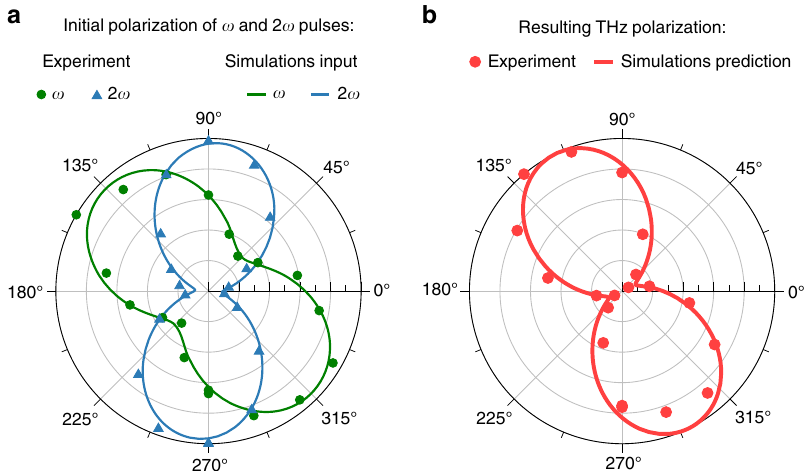
Fig. 3 Polarizations of laser and THz pulses. a . Initial polarization of the fundamental ( ω ) and second harmonic (2 ω ) pulses measured in experiment (marks) and used as input in simulations (lines). b Resulting THz polarization measured in experiment for input laser energy of 8.75 mJ (marks) and the corresponding prediction from the simulations